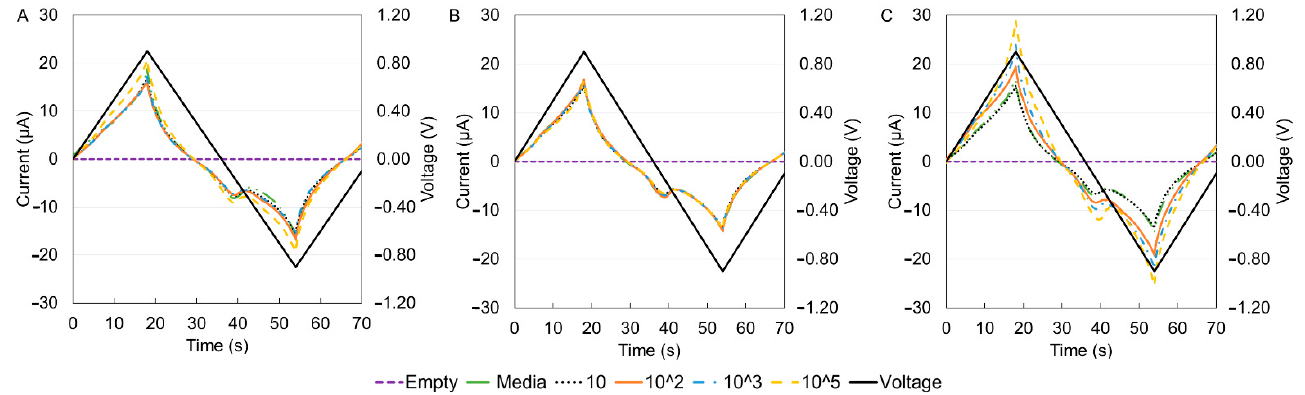
Figure 7. Current versus time and voltage versus time curves for the three types of cells from the drop sense technology. ( A ) THP-1, ( B ) DCs, ( C ) MACs. RPMI full media supplemented with 10% FBS used to dilute the cells. It was also used as the media. Measurements were conducted using a two nickel electrode configuration, scan range of − 0.9 V to 0.9 V and a scan rate of 0.04 V/s.